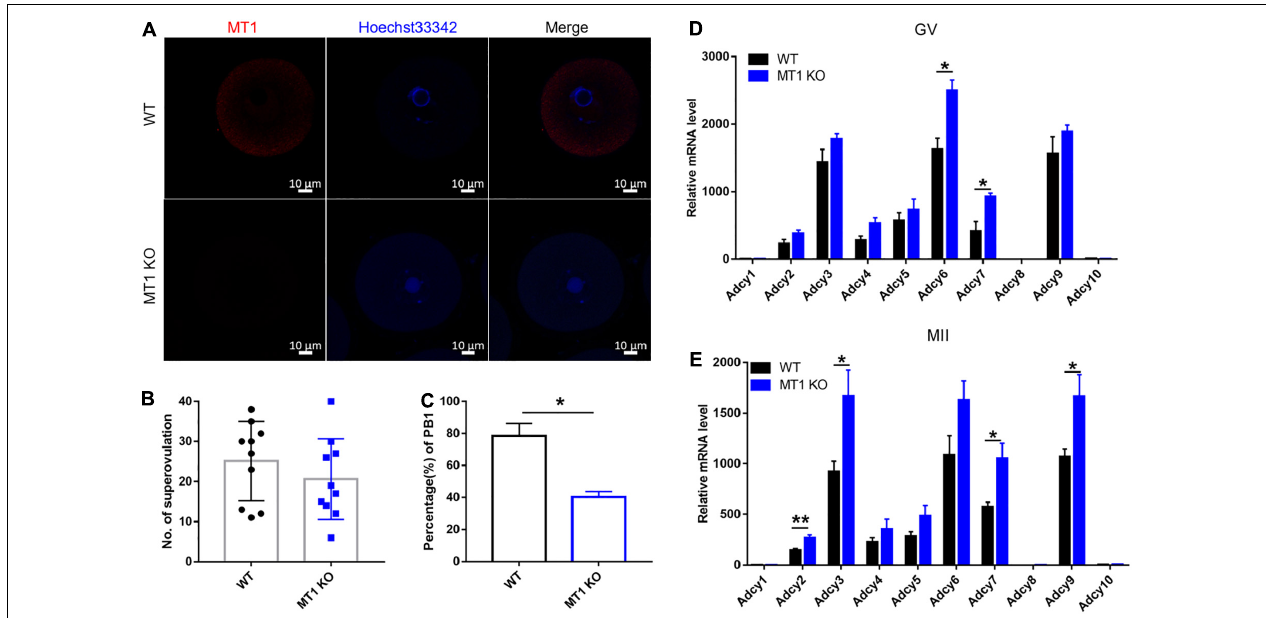
FIGURE 4 | Effects of MT1 KO on mouse oocyte maturation and cAMP synthesis ability of the ovary. (A) Images of immunofluorescence of MT1 at the GV stage in WT and MT1 KO oocytes. Bar = 10 µ m. (B,C) The number of superovulated oocytes and the rate of PB1 in WT and MT1 KO oocytes. No. of superovulation: n = 7; PB1: n = 4. (D,E) The mRNA level of cAMP synthases in the ovaries of WT and MT1 KO mice detected by qPCR. Data represent the mean with SEM. (* P < 0.05, ** P < 0.01) vs its respective group, determined by one-way ANOVA followed by Tukey post hoc comparisons ( n = 5).